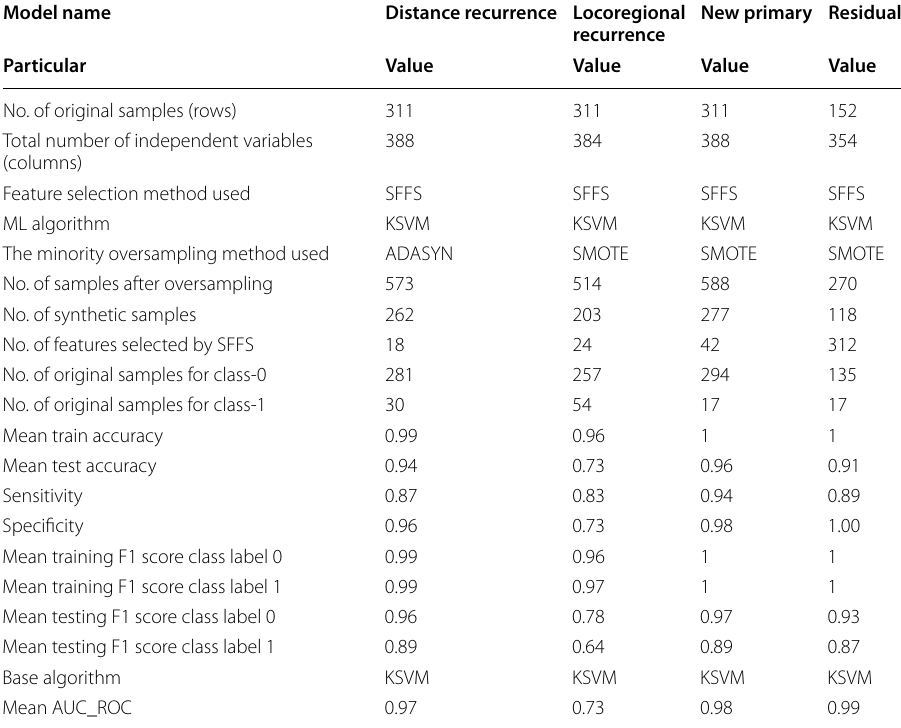
Table 3 Results from test dataset for distant recurrence, locoregional recurrence, new primary and residual models using KSVM algorithm using its optimal hyperparameters